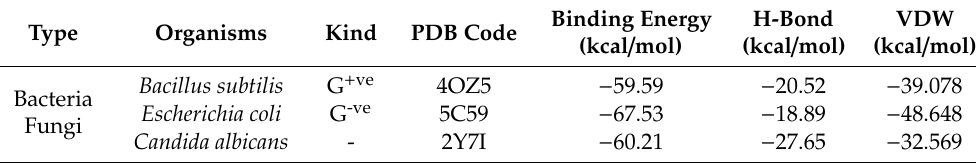
Figure 5. Molecular docking of 2-thiouracil against ( a ) Bacillus subtilis ; ( b ) Escherichia coli and ( c ) Candida albicans . Table 3. Binding energy profile of 2TU against microbes.